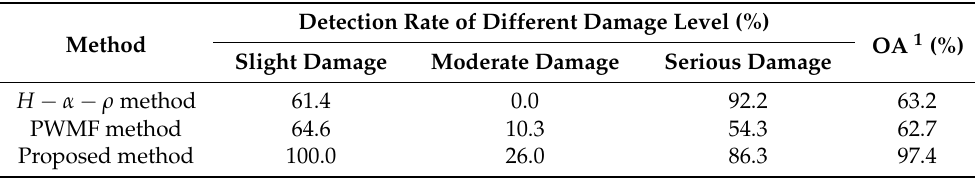
Table 8. Accuracy evaluation results of damage maps from different methods in Ishinomaki.